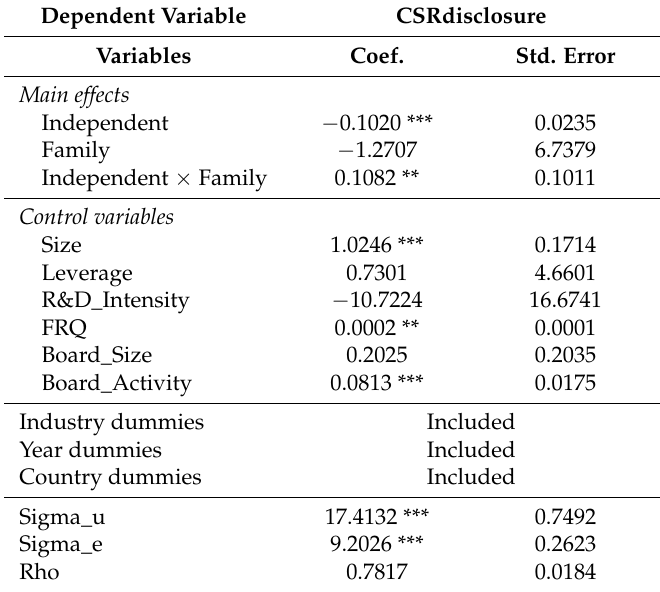
Table 6. The Impact of Board Independence on CSR Disclosure in Family owned